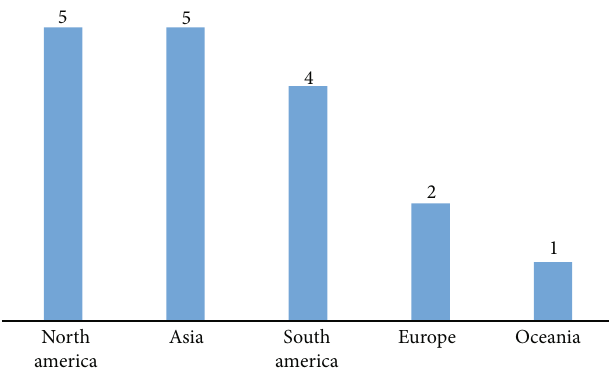
Figure 2: Number of articles per